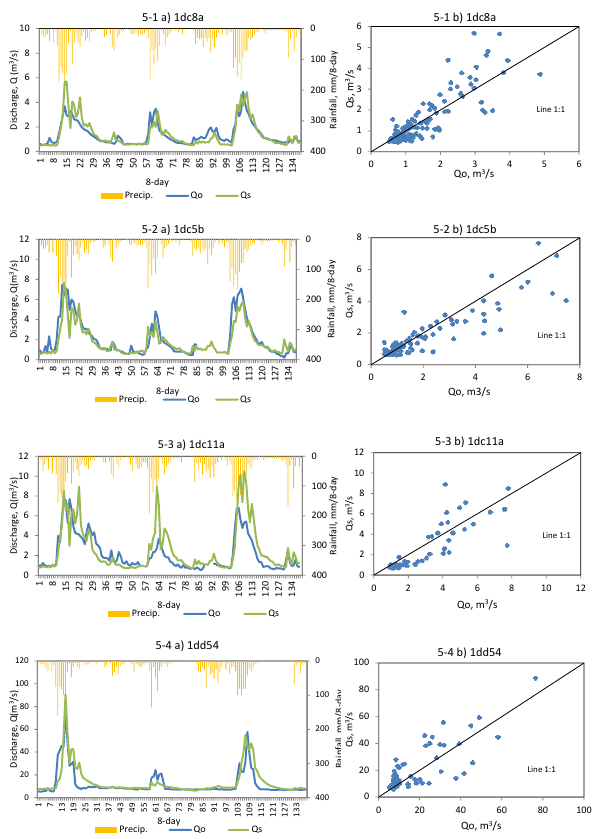
Figure 5. (a) Comparison of observed ( Q o ) and the simulated dis- charge ( Q s ) and precipitation at the outlet points for calibration period 2008 (8-day periods 1–46) and validation 2009 and 2010 (8-day periods 47–138) in the upper Pangani River basin; (b) the corresponding scatter plots of Q o and Q s for four upstream gauge